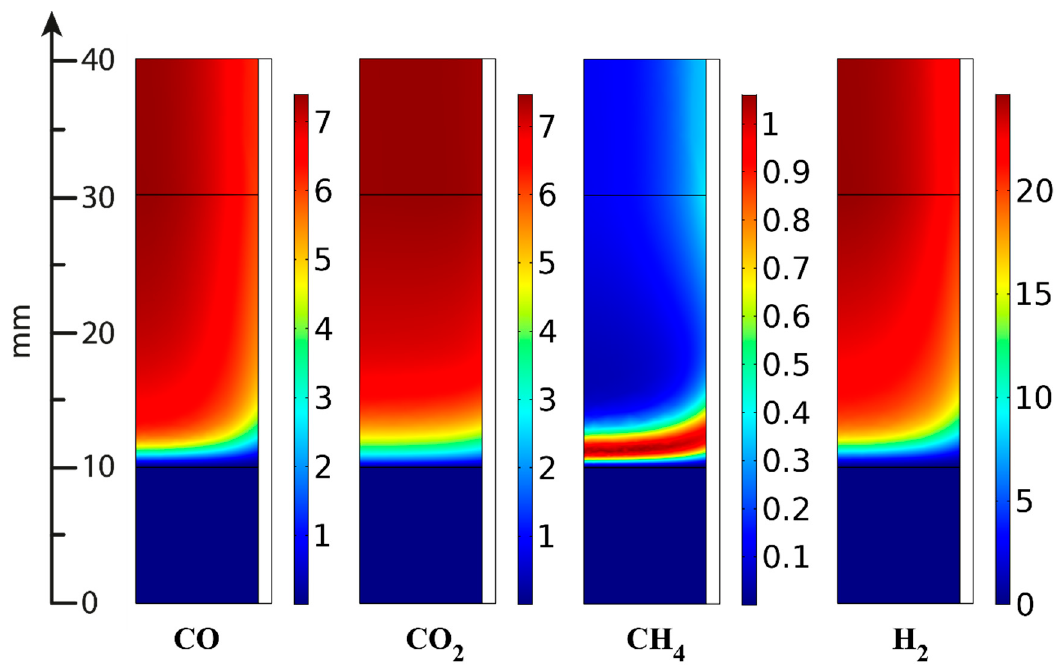
Figure 22. C 16 H 34 , water, C 2 H 6 and C 2 H 4 concentrations (vol.%) distribution in ATR [95].